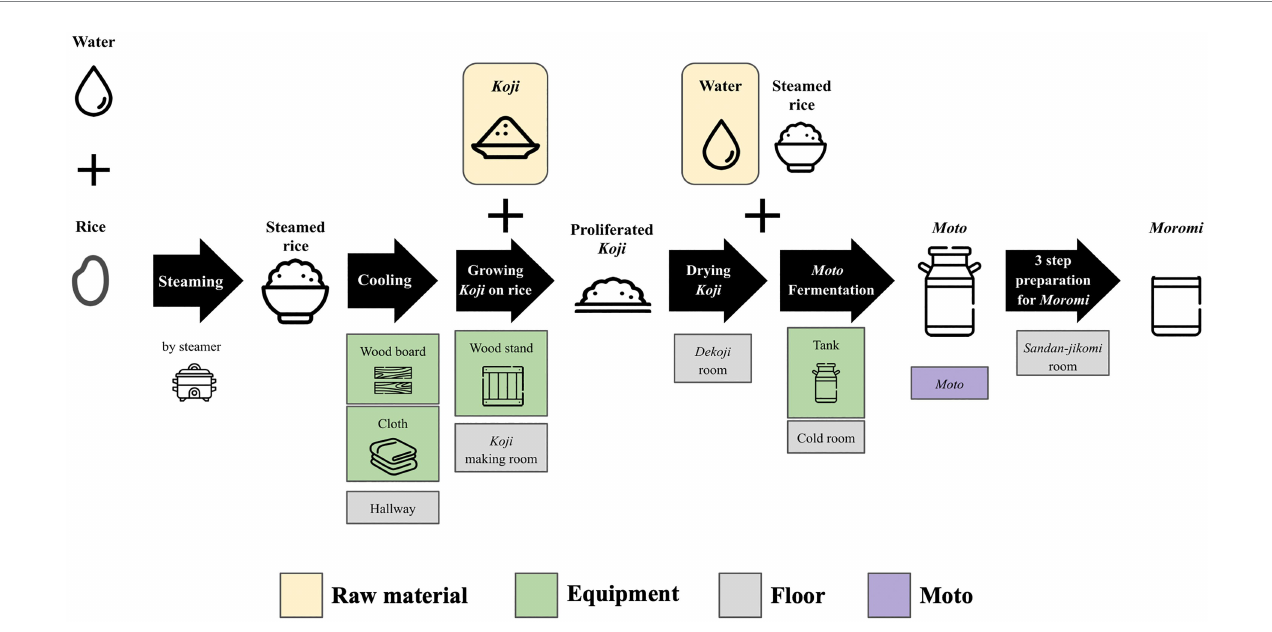
FIGURE 1 An overview of multiple processes for Sake brewing with sampling targets in the study. The group of Floor includes the brewery’s floor samples. The group of Raw materials includes water and Koji . The group of Equipments includes the wood board, wood stand, cloth, and tank for Moto Fermentation. 10 samples with grid lines were collected in this study. Sample collection was performed in duplicate. A fungus called Aspergillus oryzae , which is capable of secreting amylases, is cultivated on steamed rice to create Koji . This proliferated Koji , along with steamed rice and water, is then placed in an open-top tank to initiate the fermentation process and produce Moto . The starter is subsequently mixed with additional Koji , steamed rice, and water, and fermentation for a period of 3–5 weeks is done to make Moromi through three-step preparation ( Sandan-jikomi ). Moromi is separated into Sake and spent rice by a filter press.